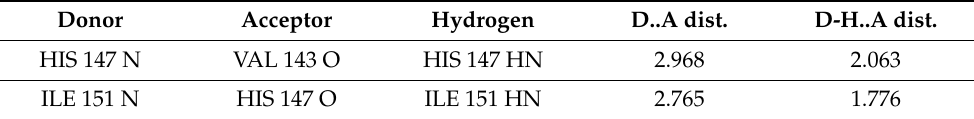
Table 3. Hydrogen bonds of His147 in the wild-type CCT5 subunit ATP bound. Constraints relaxed by 0.4 angstroms and 20 degrees 1